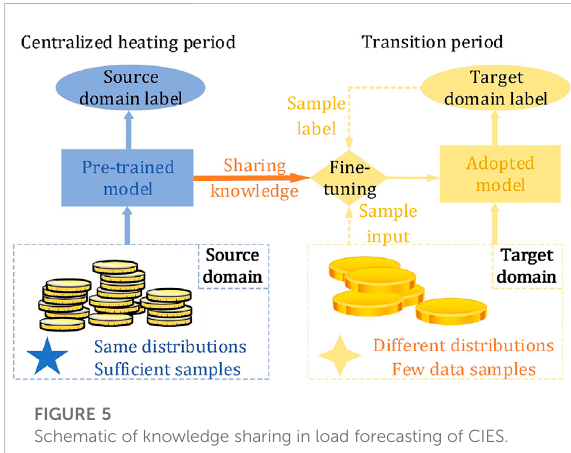
FIGURE 5 Schematic of knowledge sharing in load forecasting of